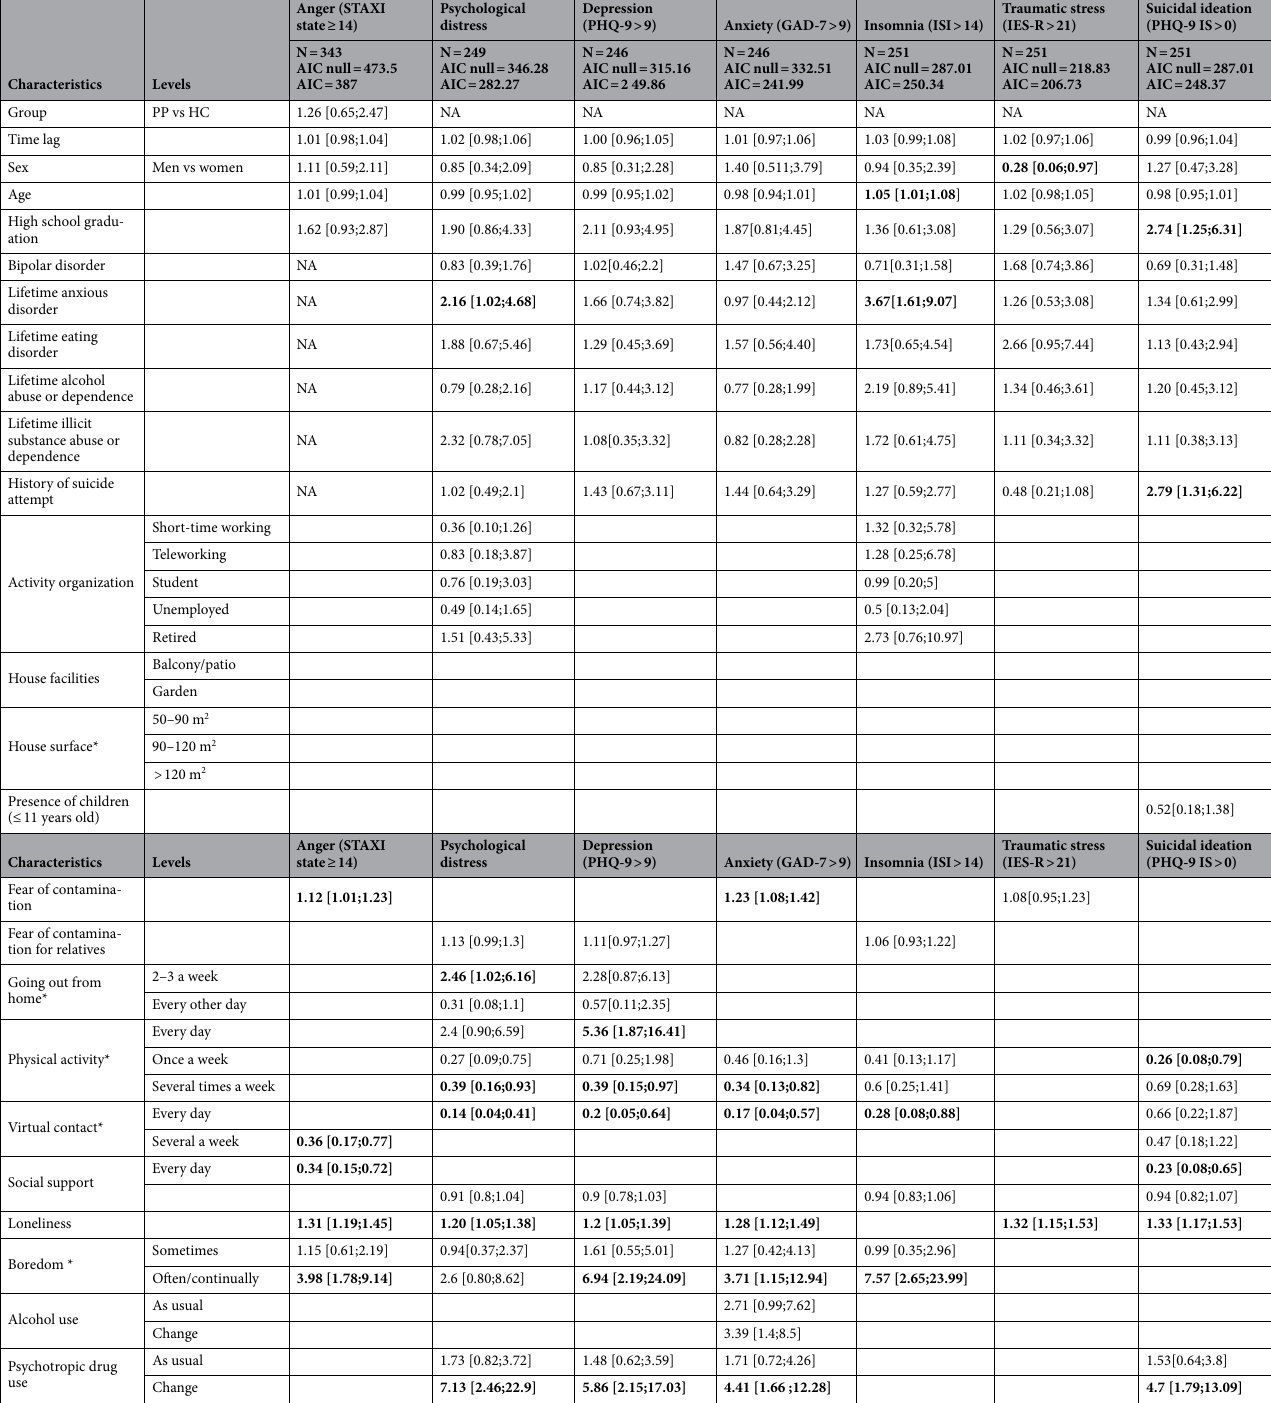
Table 3. Predictors of psychological outcomes (multivariate models selected by Step AIC). Continuous covariables are age, loneliness (Likert scale), social support (Likert scale), fear to be contaminated (Likert scale), fear of contamination for relatives (Likert scale). Socio-demographic variables are forced in the step AIC process as well as lifetime psychiatric diagnoses when considering only PP. N, AIC for the null models (including only the intercept) and AIC for best models are presented. Anger state is evaluated for the whole sample (HC and PP) without taking into account psychiatric diagnoses. Other psychological outcomes were evaluated for PP only. STAXI state-trait anger expression inventory, PHQ 9 Patient Health Questionnaire, GAD‑7 Generalized Anxiety Disorder, IESR impact of Events Scale–Revised, ISI Insomnia Severity Inventory, PHQ9 IS item of PHQ-9 assessing suicidal ideation. *Base levels (intercept) for qualitative variables with more than two levels are : regular work, house without facilities, surface < 50 m 2 , to go out from home once a week or less, no physical activity, poor frequency of virtual contact, no alcohol consumption, no psychotropic drug use and no